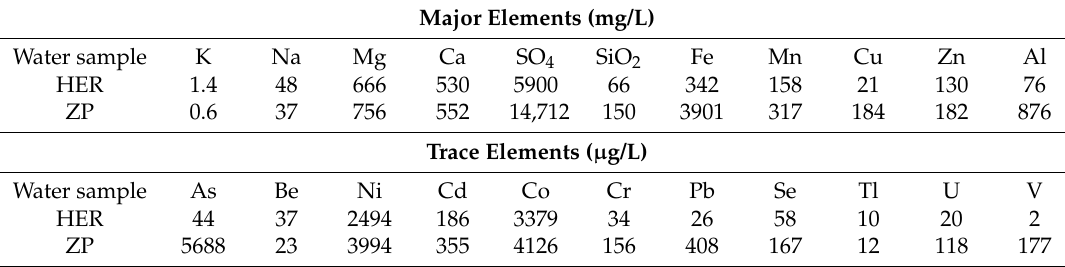
Major and trace element concentration in mine waters selected to synthesize the schwertmannite and hydrobasaluminite samples used in this study. HER—Herrer í as mine; ZP—La Zarza